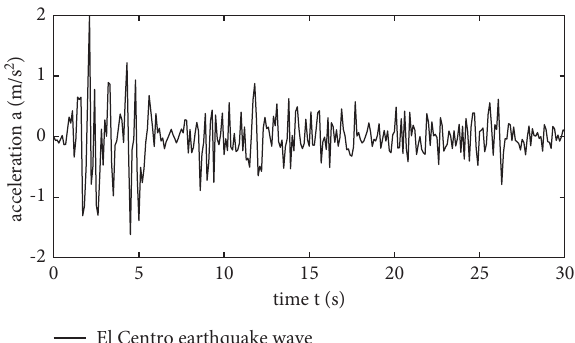
Figure 5: Adjusted El Centro seismic wave with 8 ° fortification